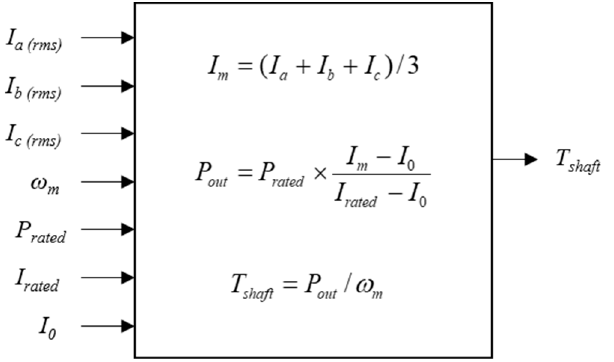
Figure 9. No load current method procedure.